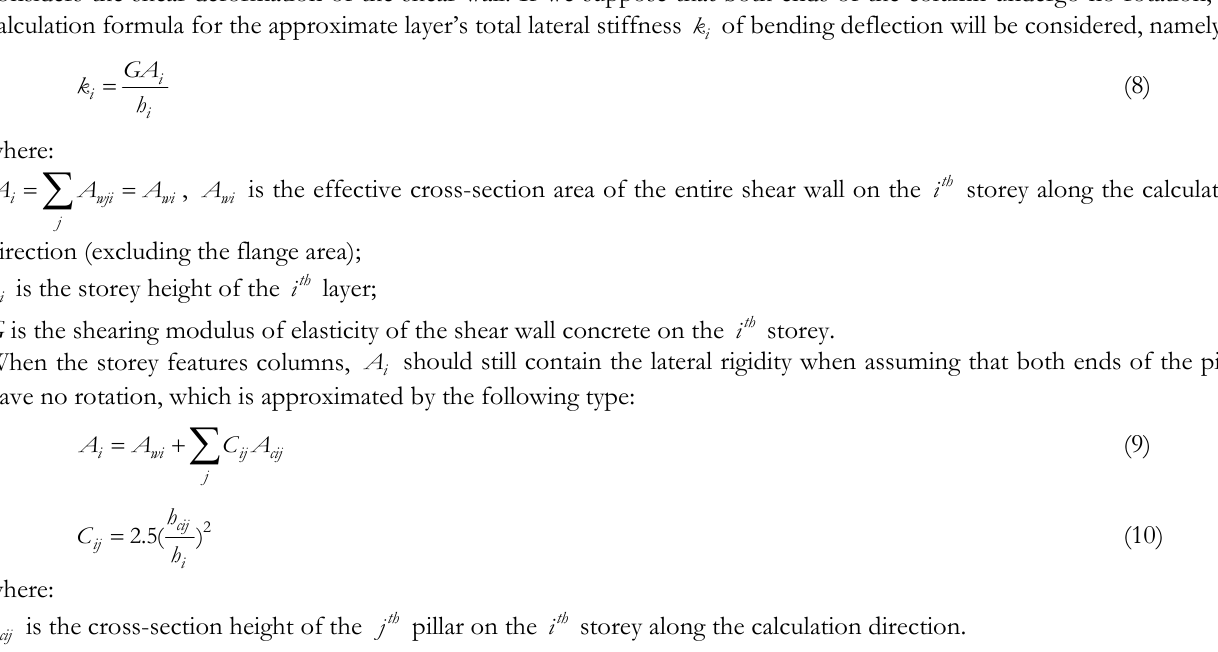
storey along the